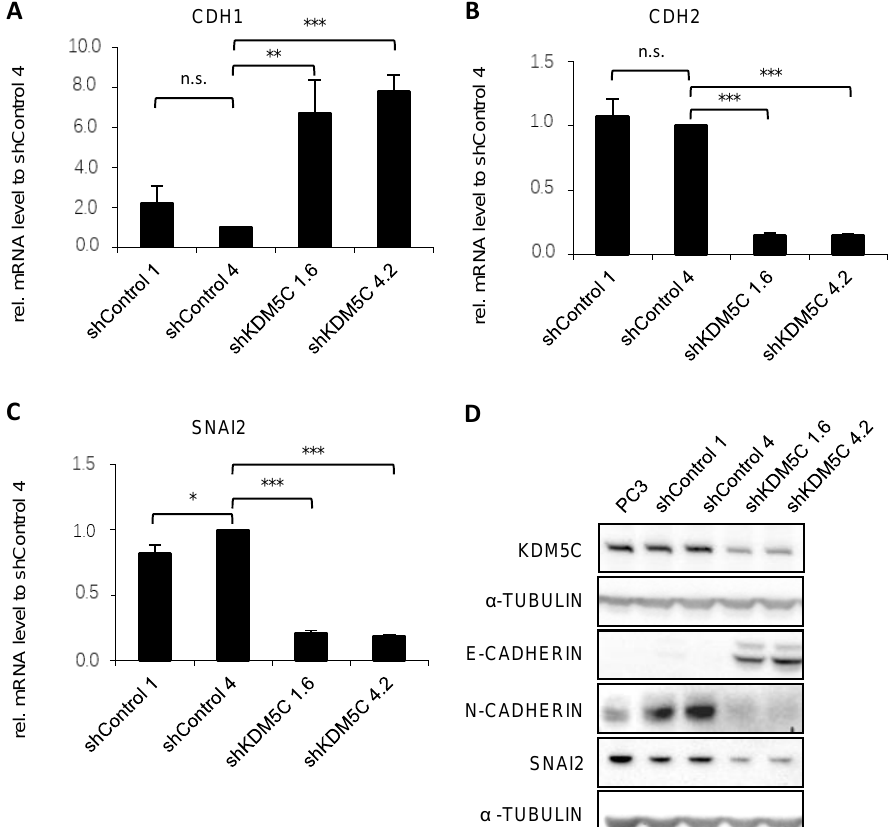
Figure 3. Differential expression of epithelial and mesenchymal markers (( A ) CDH1; ( B ) CDH2; and ( C ) SNAI2) in PC3 and shRNA-transduced cell clones. qRT-PCR analysis of mRNA expression in GFP control as well as KDM5C knockdown clones. mRNA expression was normalized to the nuclear housekeeper TBP in ( A , C ) and HPRT in ( B ) and in relation to the shControl 4. Error bars represent standard error of the mean from three independent experiments. ( D ) Representative Western blot of the expression of KDM5C and EMT markers in PC3 cells and the shRNA-transduced cell clones. Western blot shows the expression of epithelial marker E-CADHERIN (CDH1) and its transcriptional repressor SNAI2 as well as the typical mesenchymal marker N-CADHERIN (CDH2) in GFP control and KDM5C knockdown clones. α -TUBULIN serves as a loading control. (n.s. = not significant; * = p < 0.05; ** = p < 0.01; *** = p < 0.001).